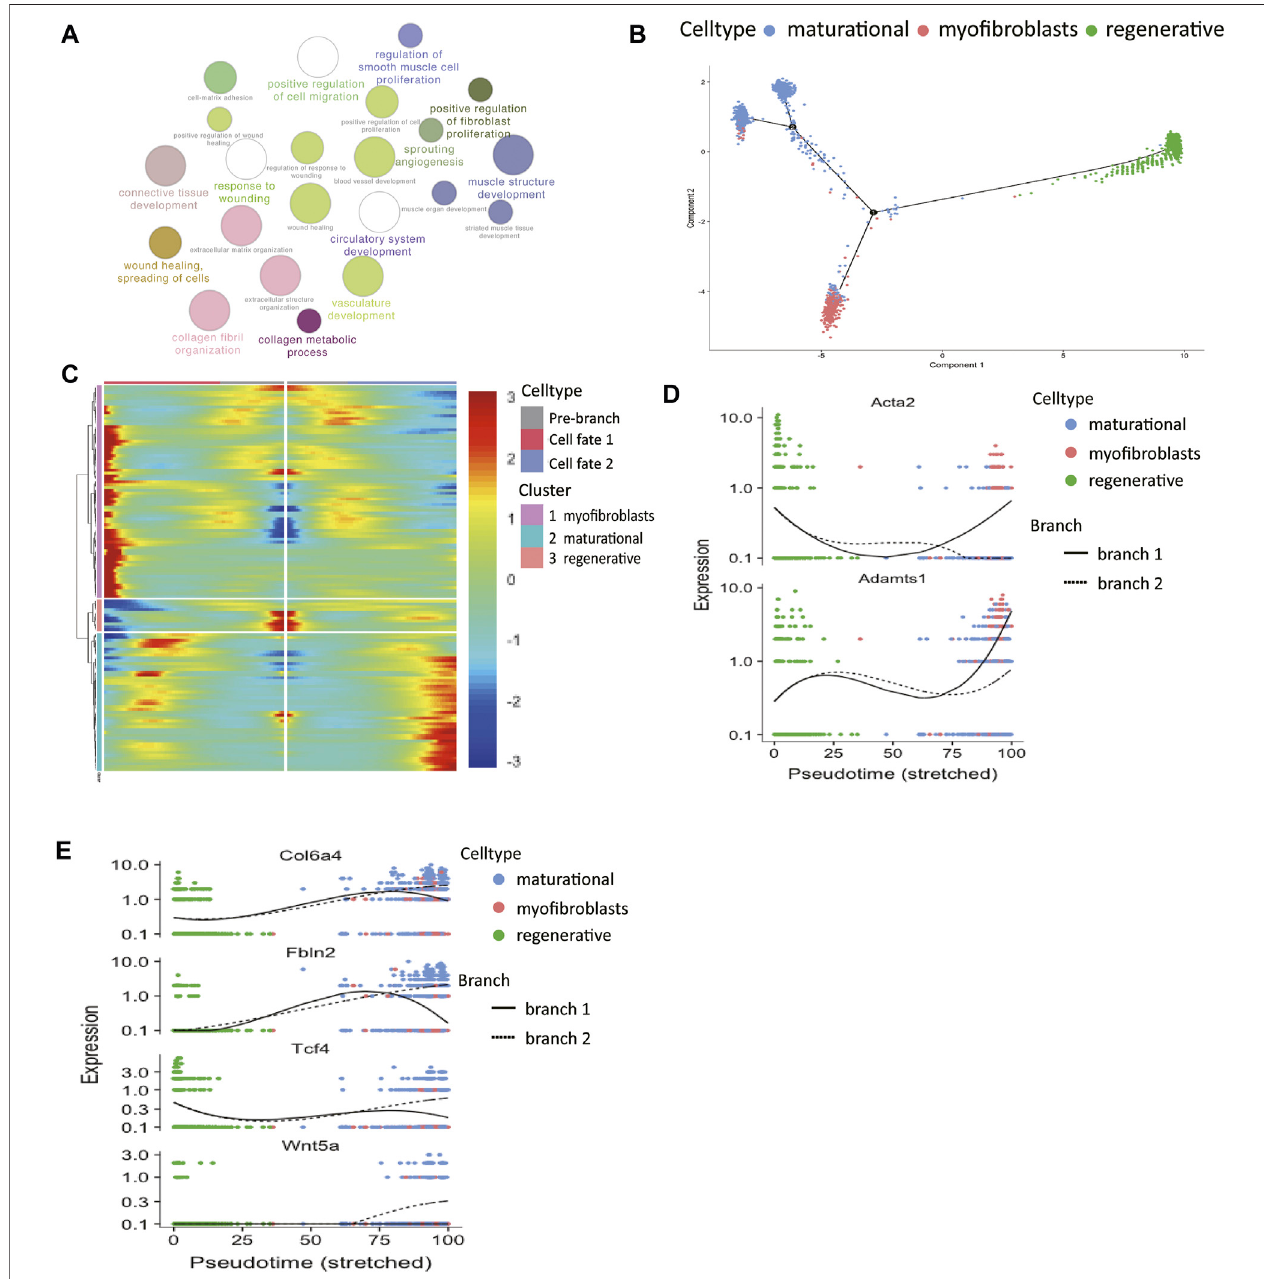
FIGURE 3 | The molecular trajectory of stromal cells in the two estrus stages. (A) Gene ontology analysis of differentially upregulated genes in myo fi broblasts. (B) Monocle generated the pseudotemporal trajectory of stromal cells in different physiological stages. (C) Heat map for clustering the signi fi cantly branch-1 dependent genes that affected cell fate decisions into three clusters. q < 1E-06. The expression levels of representative genes of (D) myo fi broblasts and (E) maturational stromal cells were shown in the line plots.